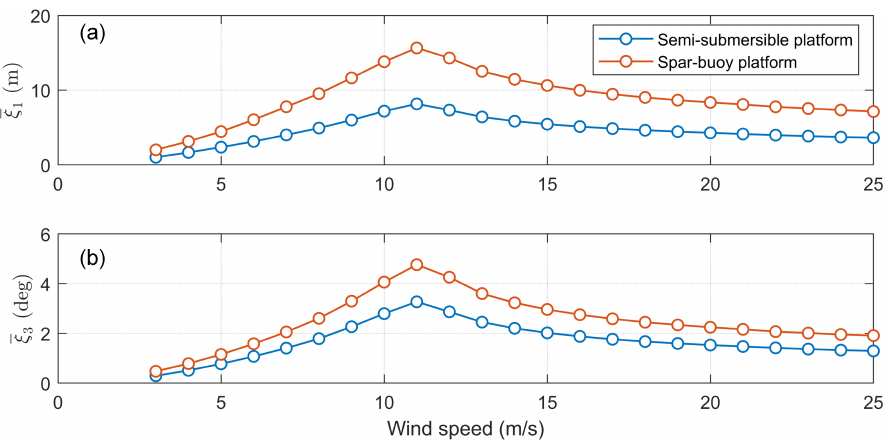
Figure 7. Mean of motion RAOs under different wind speeds: ( a ) Surge; ( b ) Pitch.